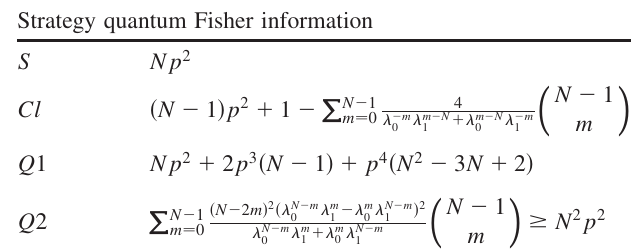
bound on the phase uncertainty, (cid:3) (cid:5) (cid:5) 1 = classical noise is equal to p 2 in strategies S and Q 2 and is independent of N . The phase uncertainty for each strategy is plotted as a function of p in Fig.